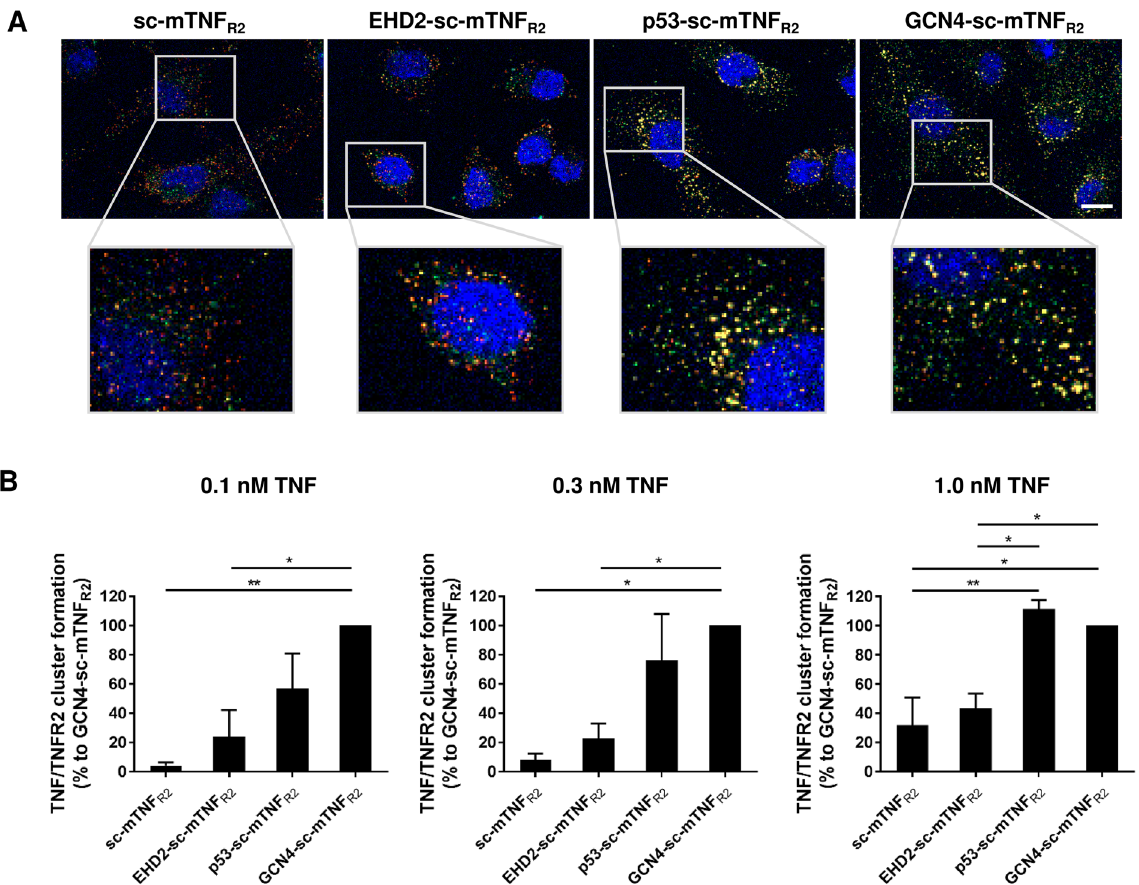
Figure 4. Dodecameric TNF muteins exert elevated TNF/TNFR2 cluster formation ( A ) BV-2 cells were incubated with the oligomerized TNF muteins (0.1, 0.3, 1.0 nM) for 15 minutes. Then cells were fixed and localization of TNFR2 (red) and oligomerized TNF muteins (green) was visualized by immunofluorescence microscopy. DAPI was used to counterstain cell nuclei. Fluorescence was analyzed using a Zeiss Axio Observer Spinning Disc microscope. Representative pictures for stimulation with 1 nM of the oligomerized TNF muteins are shown. Scale bar: 10 µ m. ( B ) Quantification of TNF/TNFR2 clustering (n = 3 ±